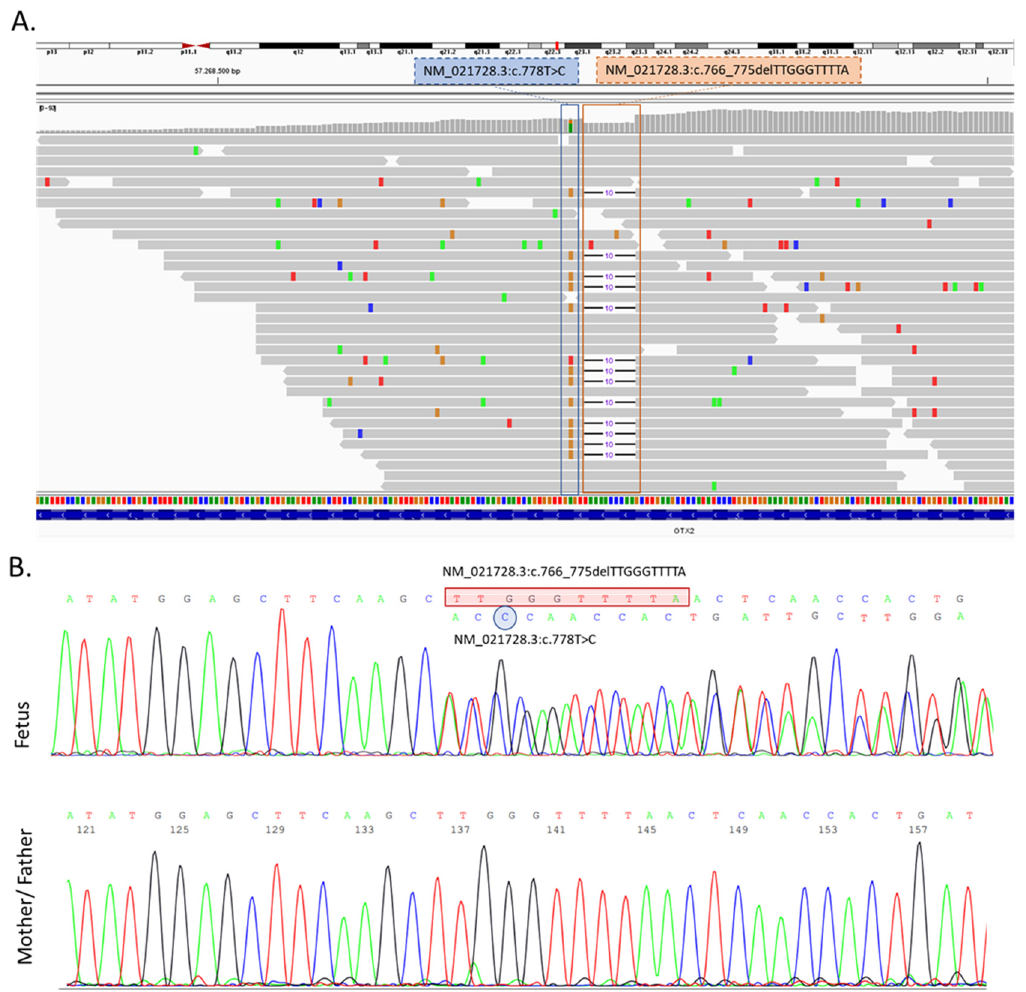
Figure 3. ( A ) Visualization of the result of the clinical exome sequencing (CES) show- ing the identified variant in the OTX2 gene by Integrative Genomics Viewer (IGV) software (https://software.broadinstitute.org/software/igv/ accessed on 1 August 2022). c.778T>C and c.766_775delTTGGGTTTTA variants were in a heterozygous status in the proband. ( B ) Sanger sequencing confirmed the identified OTX2 variants, which were not present in his